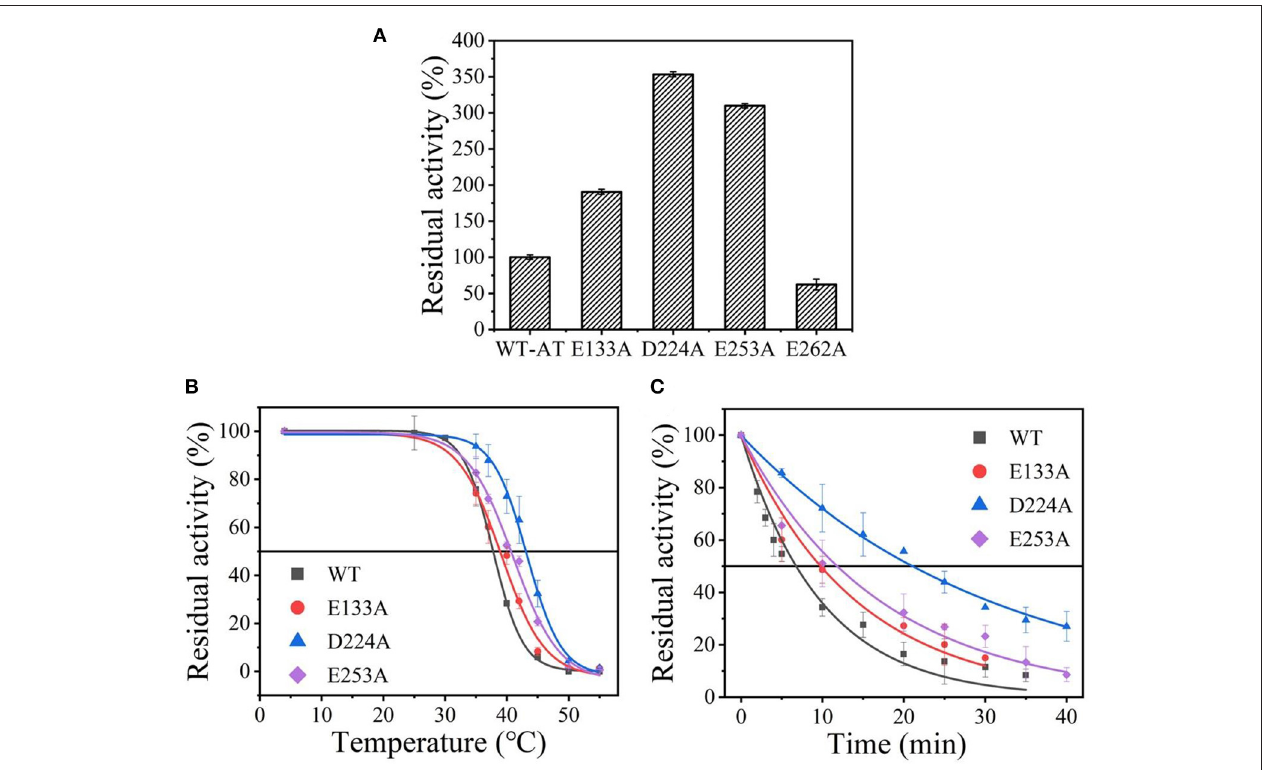
FIGURE 2 | The thermal stability of wild-type At -ATA and its mutants by the alanine scanning: (A) the enzymatic activity of wild-type At -ATA and the four variants, (B) the thermal deactivation of wild-type At -ATA and the four variants at various temperatures for 10min ( T 10 50 ), (C) the thermal deactivation half-life ( t 1 / 2 ) of wild-type At -ATA and the three variants at 40 ◦ C. Black, Wild-type; red, E133A; blue, D224A; and purple, E253A.